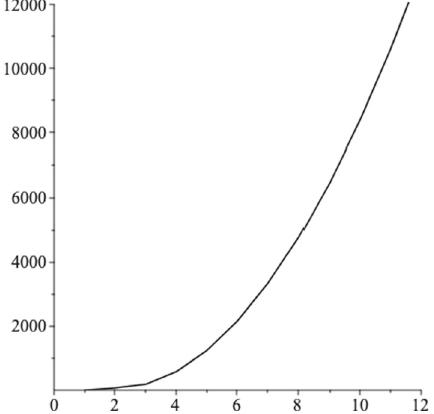
Fig. 2 The circumference of the great circle, passing through the north and south pole, versus the magnetic field b , where we set the other black hole parameters a = 6 , l = 1 , m = 7 and q = 1. The circumference with no magnetic field is equal to 71 . 9 in arbitrary